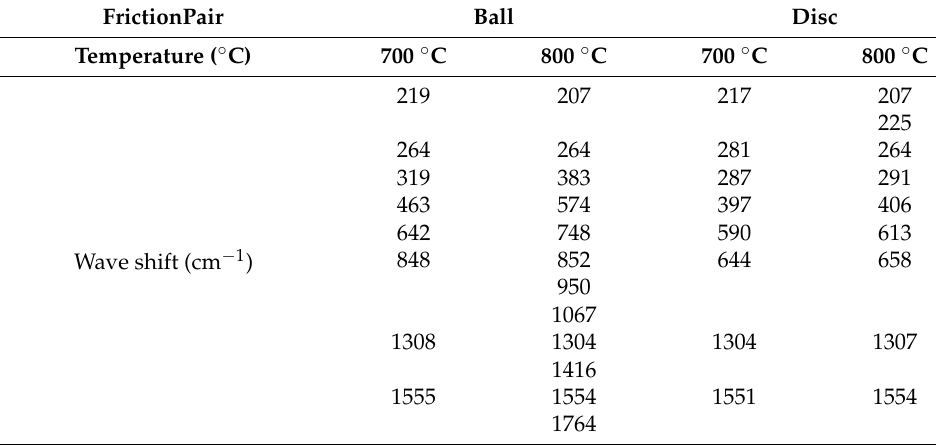
Table 1. Raman spectra of friction pair at 700 ◦ C and 800 ◦